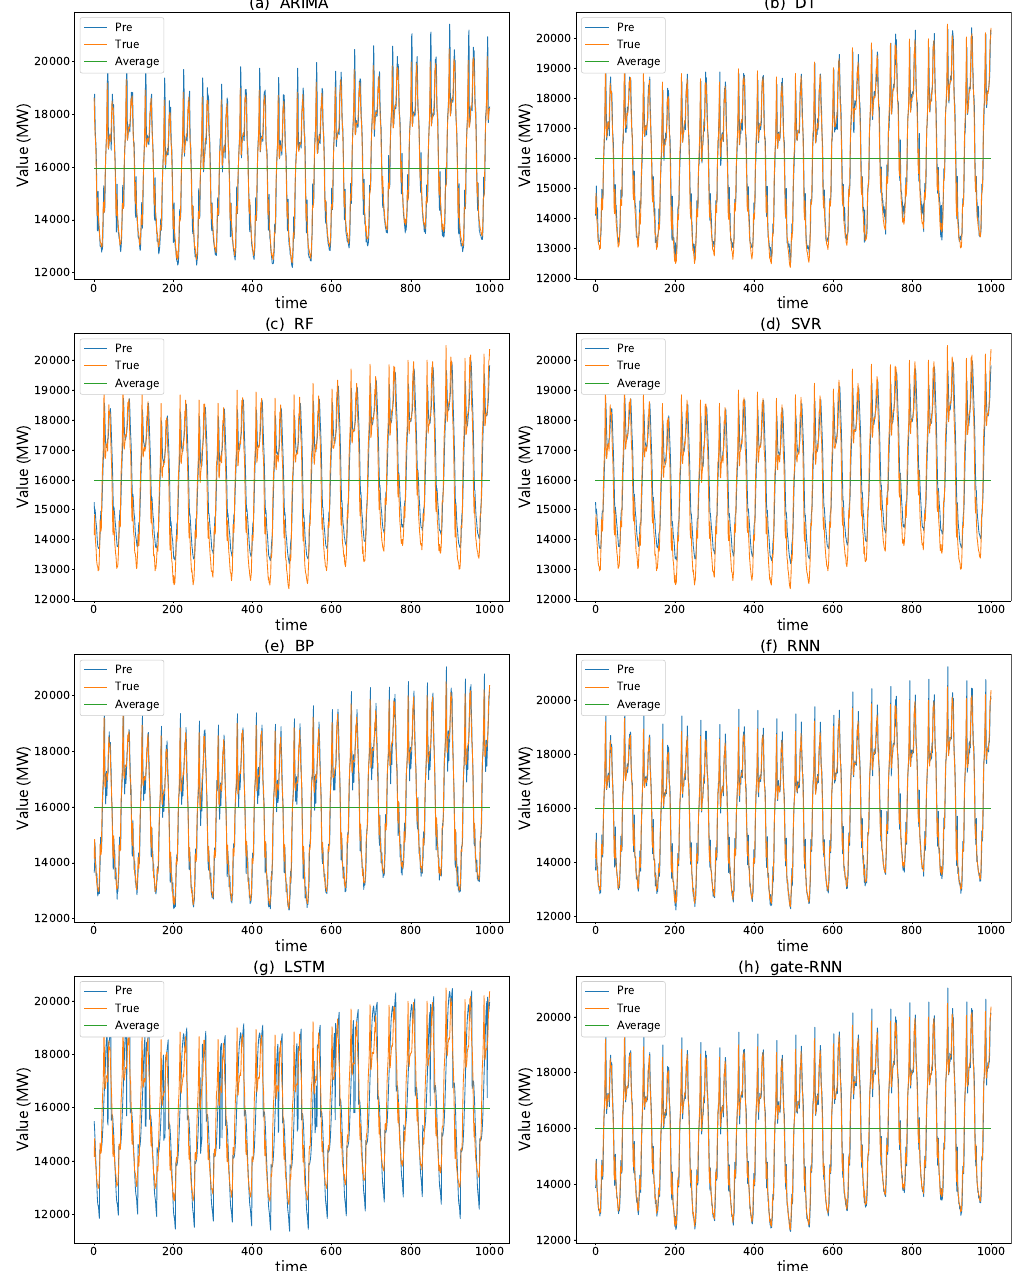
Figure 10. Visualization of the results of four types of neural networks and other four comparative approach in 30-min time scale: ( a ) results of ARIMA; ( b ) results of DT; ( c ) results of RF; ( d ) results of SVR; ( e ) results of BP; ( f ) results of RNN; ( g ) results of LSTM; ( h ) results of gate-RNN. The blue line indicates the outputs of the neural network and the orange line is the true value of the